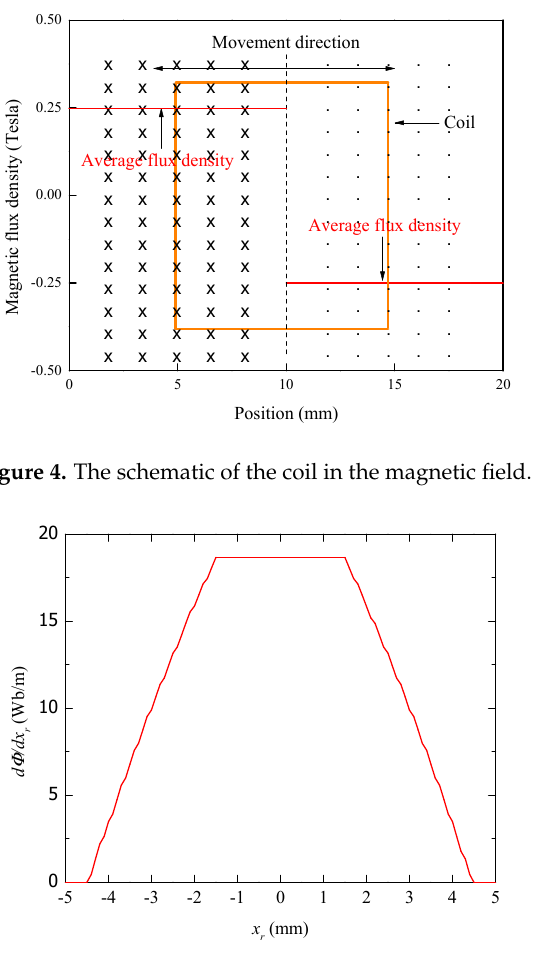
Figure 5. The rate of change of total flux versus the relative displacement.